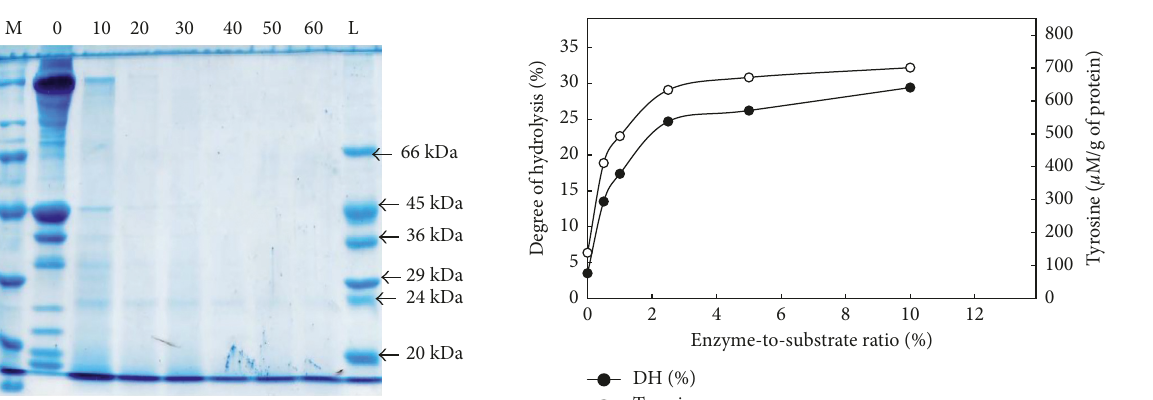
Figure 2: SDS-PAGE (10% gel) pattern of natural actomyosin during hydrolysis at 50 ° C for 60 min by the papain enzyme (lane M: wide-range molecular weight markers; lanes 0, 10, 20, 30, 40, 50, and 60: time of hydrolysis (min); lane L: low-molecular-weight